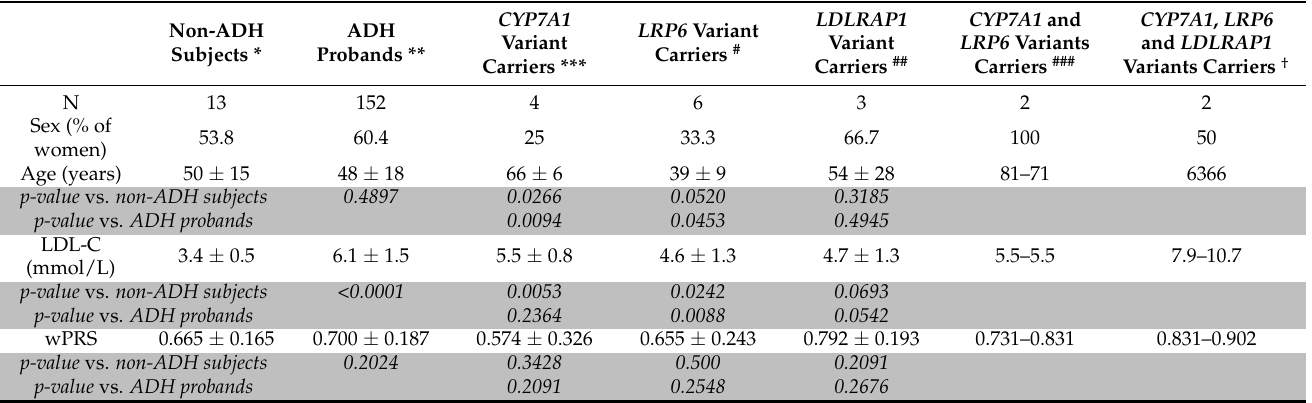
Table 4. LDL-C levels and weighted Polygenic Risk Score (wPRS) comparison among the carriers of CYP7A1 , LRP6 and/or LDLRAP1